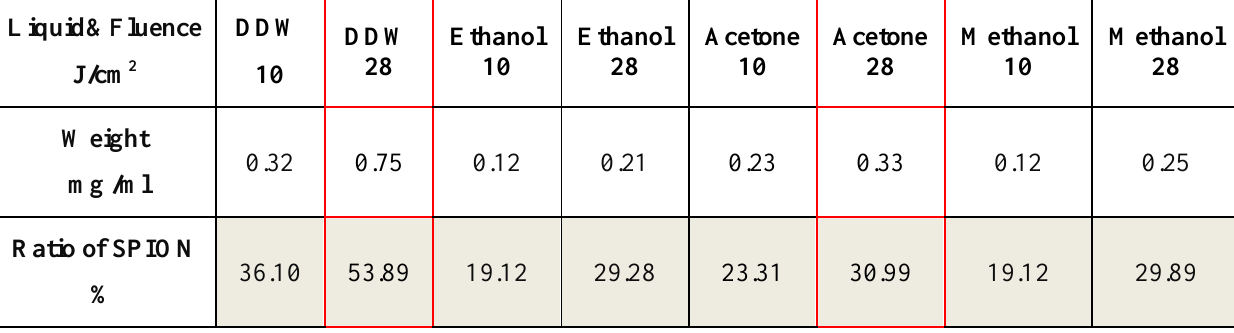
Table 6: Optimum values of SPIONs concentrations in different types of liquids with wavelength 266